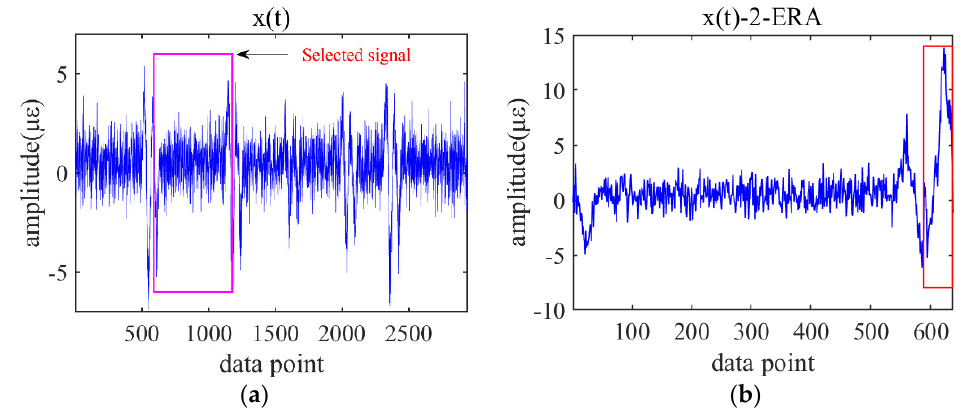
Figure 7. ( a ) Test signal x(t). ( b ) Extended signal; the red window indicates the extension result.